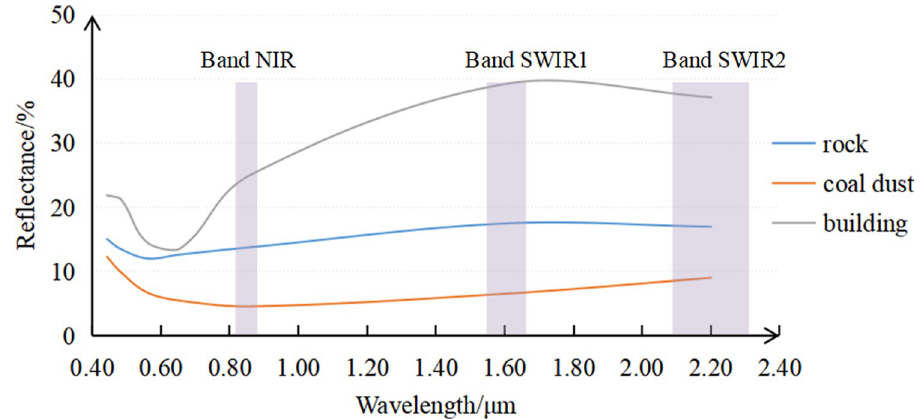
Fig 4. Spectral profiles of coal dust, rocks, and buildings.